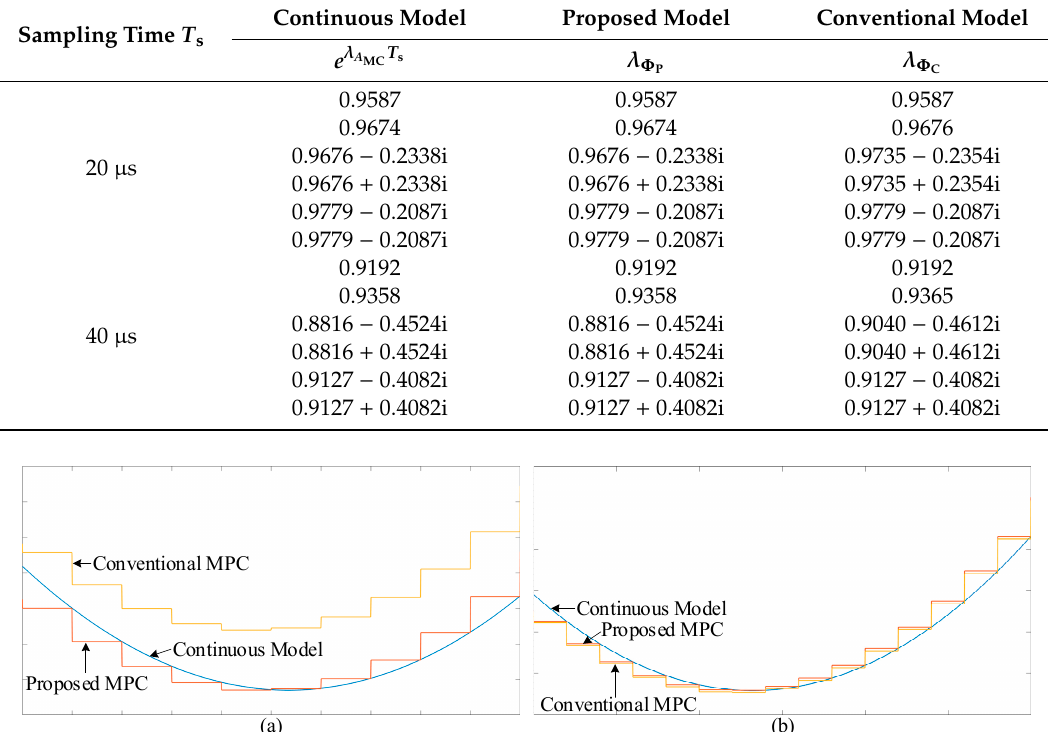
Figure 3. Prediction performance with the conventional and improved model predictive control (MPC) schemes: ( a ) the α -axis input voltage u i α ; ( b ) the α -axis output current i o α .